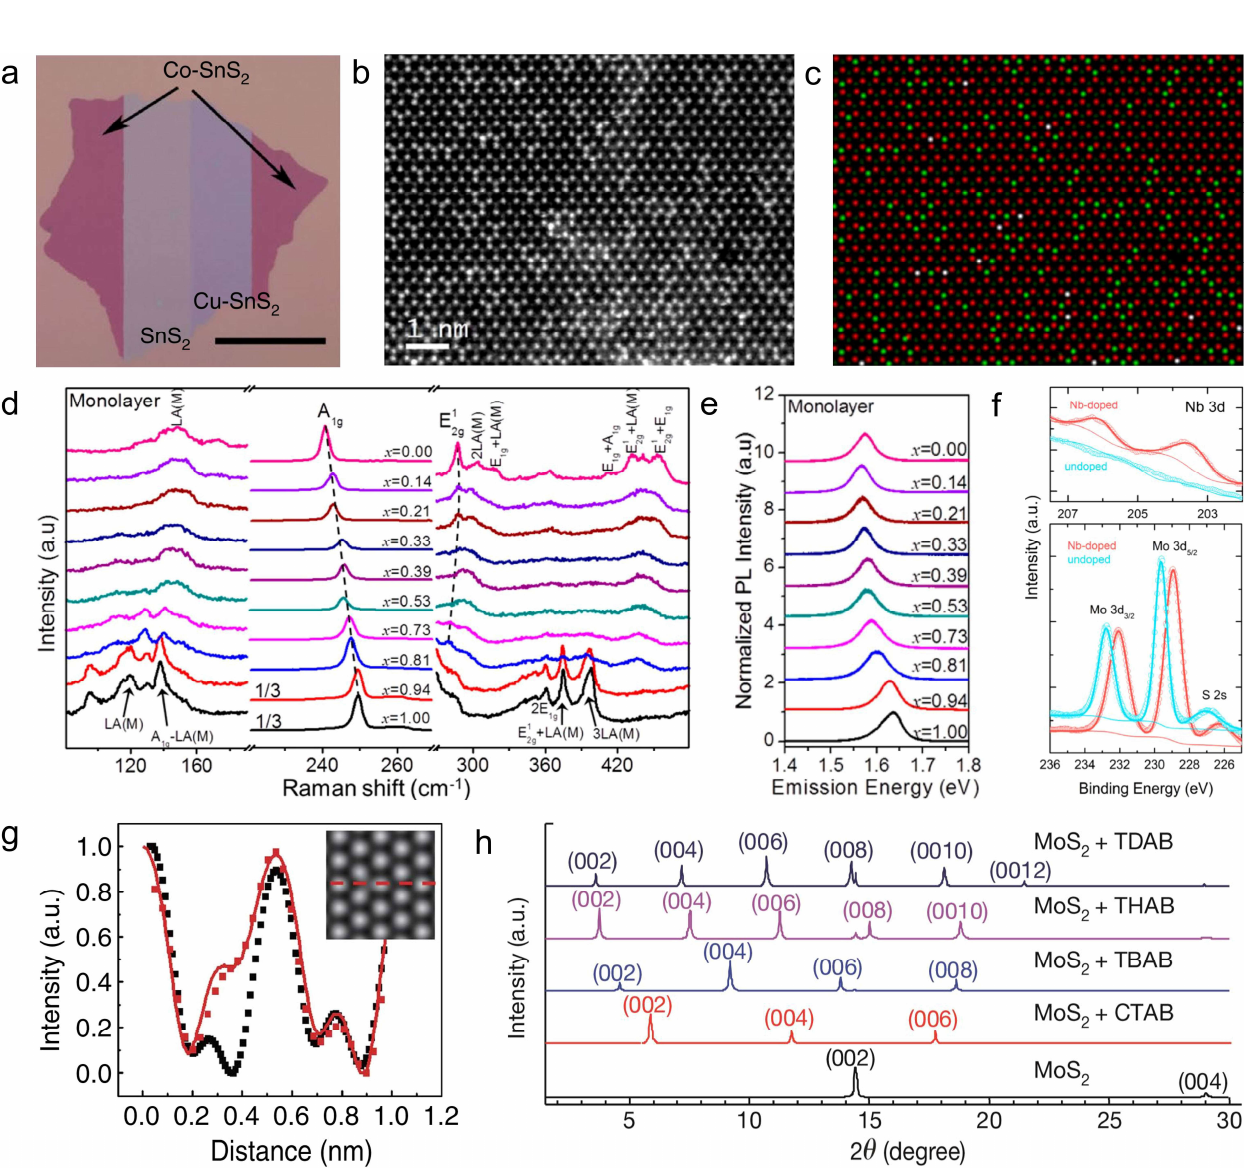
Figure 5. Characterization of 2D doped materials. ( a ) Optical microscopy image of n-type SnS 2 , p-type Cu-SnS 2 , and metallic Co-SnS 2 in-plane 2D heterostructures. Reproduced with permission from [53]. ( b ) ADF image of Se-doped MoS 2 . ( c ) Structure model obtained from histogram analysis showing the distribution of single- and double-Se substituted S 2 sites. Reproduced with permission from [47]. ( d ) Raman spectra of Mo 1-x W x Se 2 monolayers. ( e ) Composition-dependent PL spectra of Mo 1-x W x Se 2 monolayer alloys. Reproduced with permission from [48]. ( f ) XPS scans of the Nb 3d ( top ), the Mo 3d, and S 2s (both in bottom ) core-levels measured from the Nb-doped and undoped MoS 2 . Reproduced with permission from [84]. ( g ) Comparison between intensity profiles along the red dashed line and simulated high-resolution TEM image of single SV shows quantitative agreement. Reproduced with permission from [85]. ( h ) XRD patterns of pure MoS 2 and MoS 2 intercalated with quaternary ammonium molecules with four equivalent substitutional groups of an increasing chain length. Reproduced with permission from